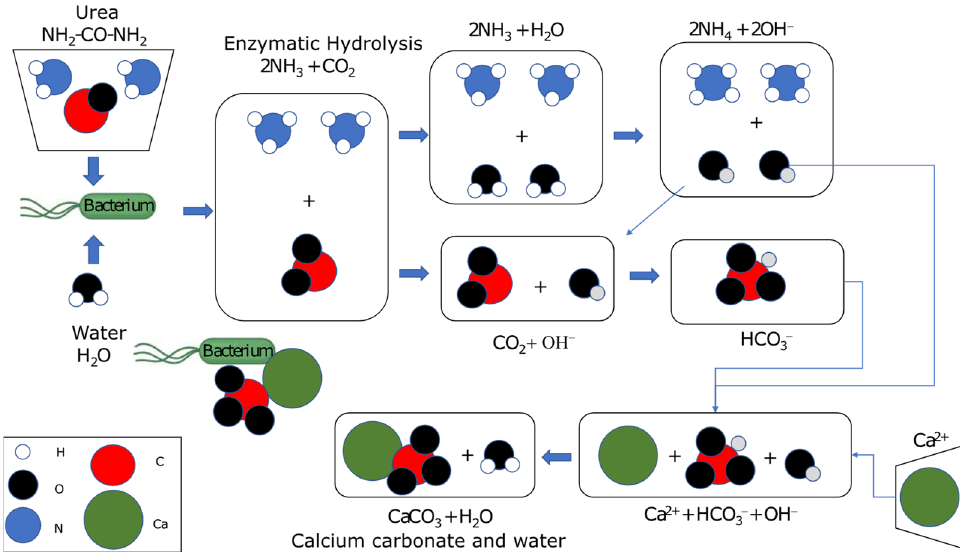
Figure 1. Microbial-induced calcium carbonate precipitation. Urea hydrolysis to carbonic acid takes 18 h to be achieved, while the reaction between carbonic acid and calcium ions occurs instantaneously for practical purposes.